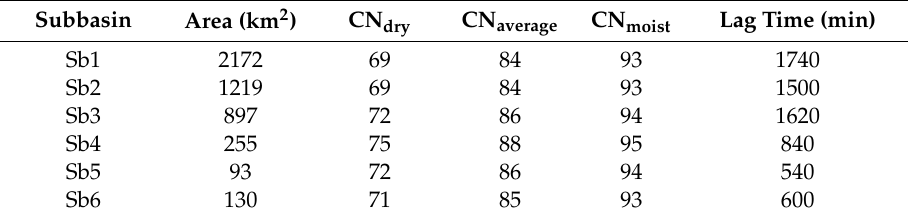
Table 1. Main hydrological characteristics of the area under